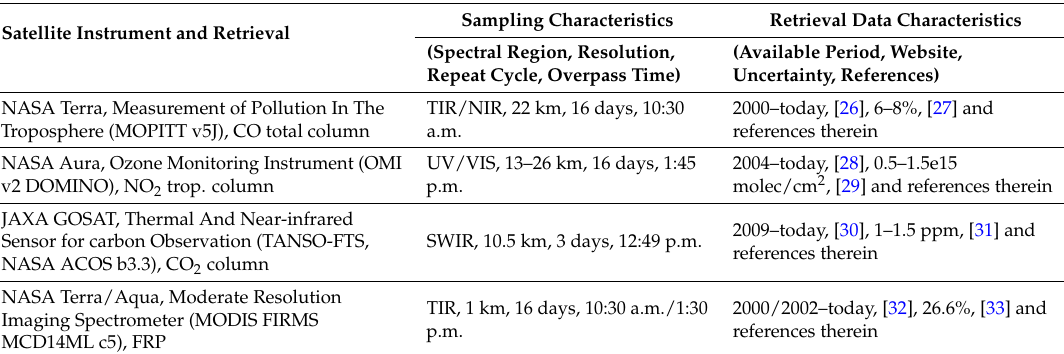
Table 1. Satellite data products used in this